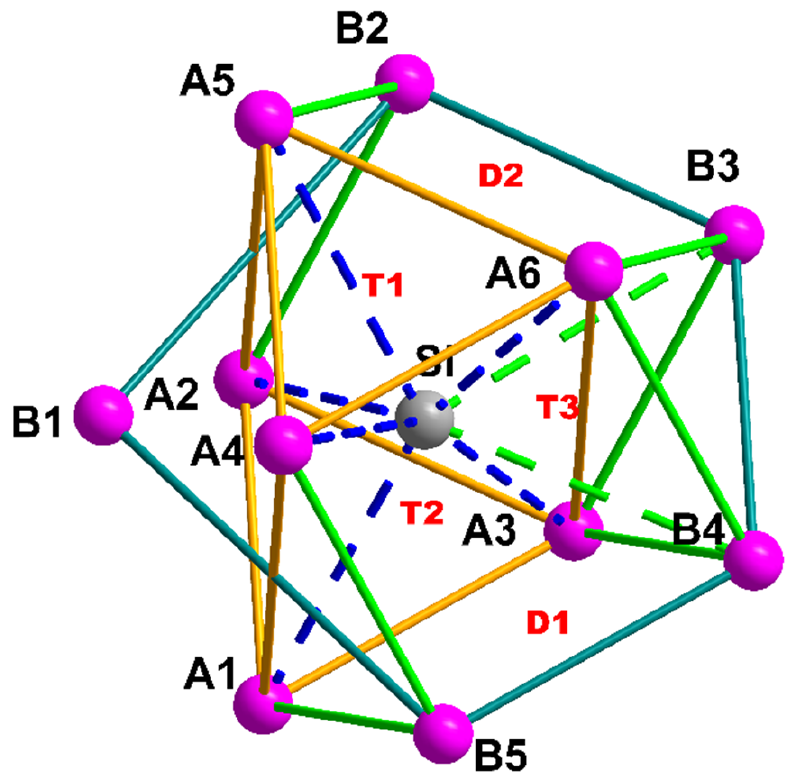
Figure 8. Arrangement of Ca cations around the Si +4 cations in all belite polymorphs. A1, A2 and A3 indicate the Ca +2 cations on the bottom trigonal face of the prism; A4, A5 and A6 indicate those at the top face of the prism; B1, . . . , B5 indicate those at the equator plane. T1, T2 and T3 and D1 and D2 indicate the sites of oxygen anions in different belite polymorphs.